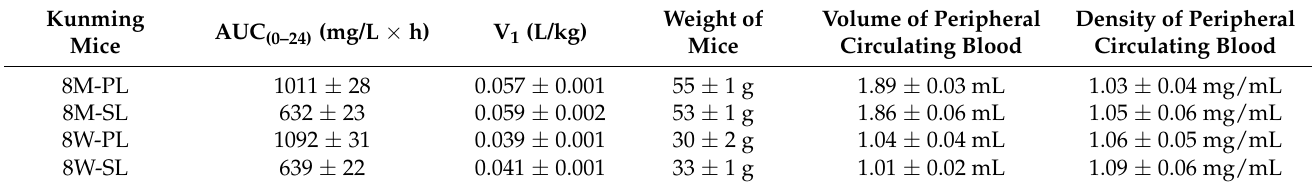
Table 3. EPI pharmacokinetic parameters and blood parameters in 8M versus 8W mice (n = 3).